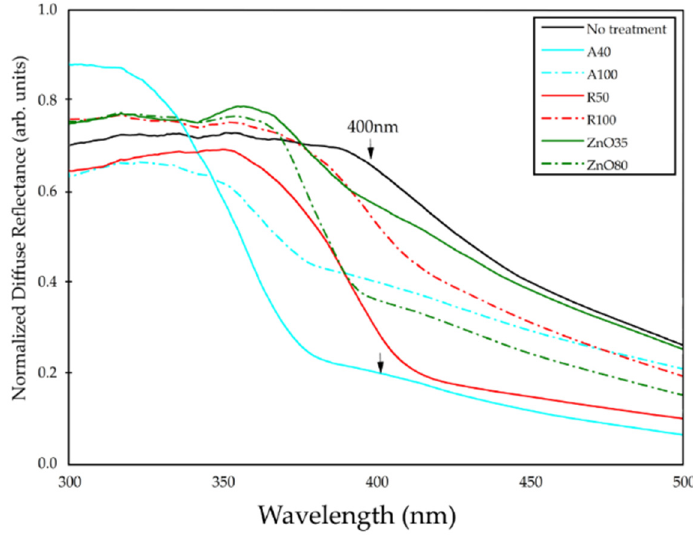
Figure 6. UV–Vis absorbance between 300–500 nm for untreated control and NP-treated samples. Changes in color of irradiated wood surfaces expressed using the CIE L*a*b* system are shown in Figure 7. The Δ L* value (change in lightness) remained close to 0 from 0 to 2880 min, indicating that most color changes in samples were due to reddening and yel- lowing. The Δ L* in most samples treated with NPs increased initially, from 0 to 120 min, and then decreased from 120 to 2880 min. This trend was not observed in samples treated with ZnO80. In this case, Δ L* decreased throughout the exposure period, indicating dark- ening of the surface. The Δ a* increased near 1 color unit for untreated control samples from 0 to 2880 min of exposure. Similar increases were also observed in samples treated with ZnO80 and R100. Less pronounced changes occurred in samples treated with ZnO35 and R50, and even smaller changes were detected in samples treated with A40 and A100. The Δ b* values also increased in most samples over time. The highest increase, about 5 color units from 0 to 2880 min of exposure, occurred in untreated control samples, fol- lowed by R100, ZnO35, and then by Z80 and A100. A small increase in Δ b* was observed in samples treated with R50. These samples showed an increase in their blueness–yellow- ness values from 120 to 1440 min, but after that Δ b* remained constant during exposure. The opposite trend was observed for samples treated with A40, which in contrast to all other samples turned bluer rather the yellower during UV exposure. The macroscopic appearances of the treated and control samples are shown in Figure 8.